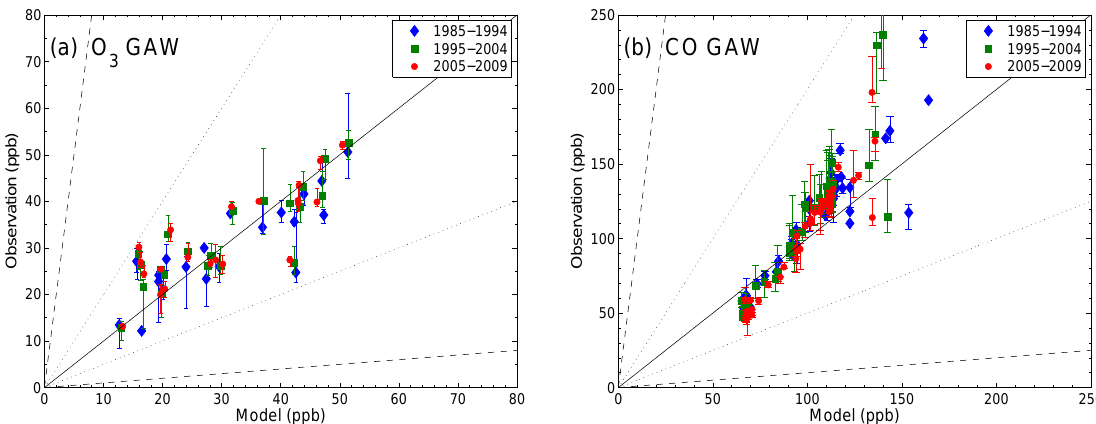
Fig. 4. The median of the observed annual means from the GAW network compared with the corresponding modelled annual mean for each decade. The comparisons are shown for O 3 (a) and CO (b) for those stations operating in all decades. The solid line shows a one-to-one correspondence. The dotted lines show a factor of 2 difference and the dashed lines a factor 10 difference between the observations and model results. The error bars added to the observations denote the maximum and minimum of the annual means in the decade.